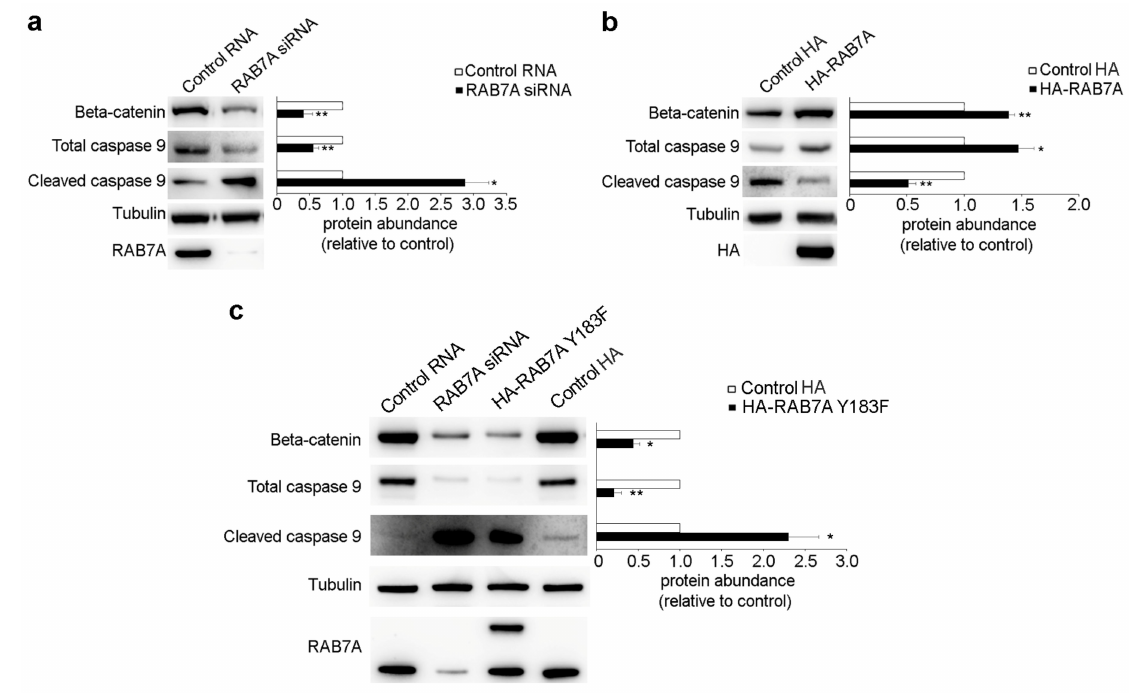
Figure 5. Modulation of RAB7A expression acts on beta-catenin and caspase 9 expression. ( a ) HeLa cells were transfected with either control RNA or RAB7A siRNA, replated 72 h after transfection and then lysed after 48 h. ( b ) HeLa cells were transfected with plasmids encoding either HA or HA-RAB7A and lysed after 24 h. ( c ) HeLa cells were treated with either control RNA or RAB7A siRNA and lysed after 5 days or were transfected with plasmids encoding HA or HA-RAB7A Y183F and lysed after 24 h. Lysates were subjected to Western blot analysis using anti-beta catenin, anti-caspase 9, anti-cleaved caspase 9, anti-tubulin, anti-HA, and anti-RAB7A antibodies. Quantifications of beta-catenin, caspase 9, and cleaved caspase 9 are shown. All data represent the mean ± s.e.m. of at least three independent experiments. * = p < 0.05; ** = p <